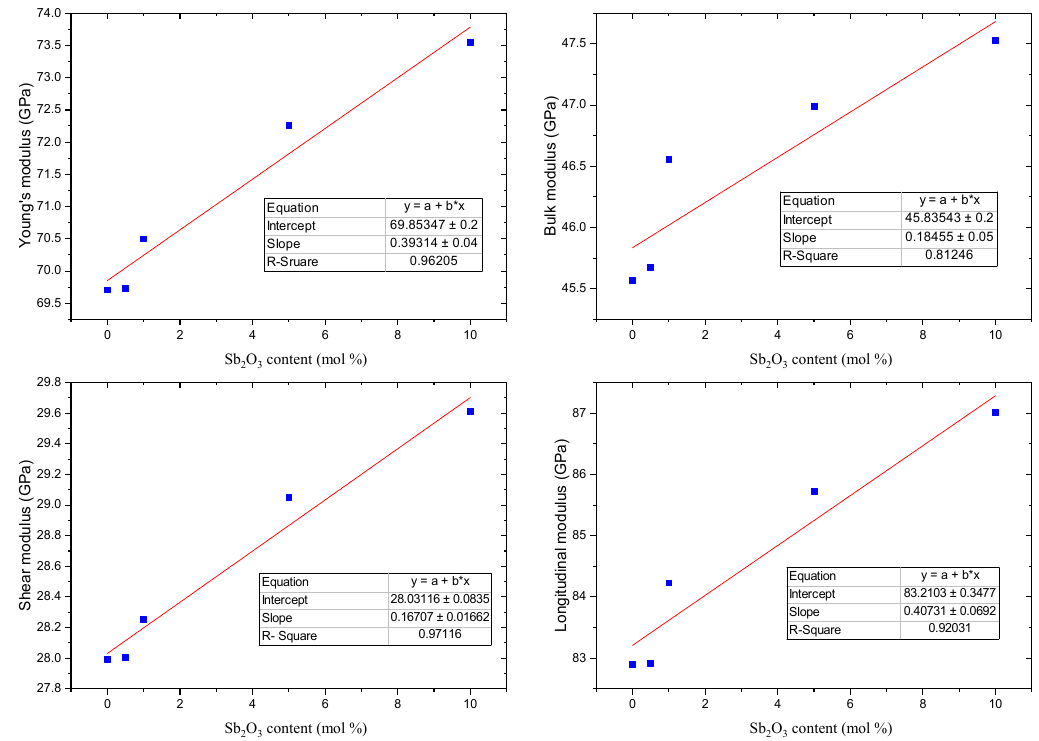
Figure 3. The variation of elastic moduli versus the Sb 2 O 3 content.